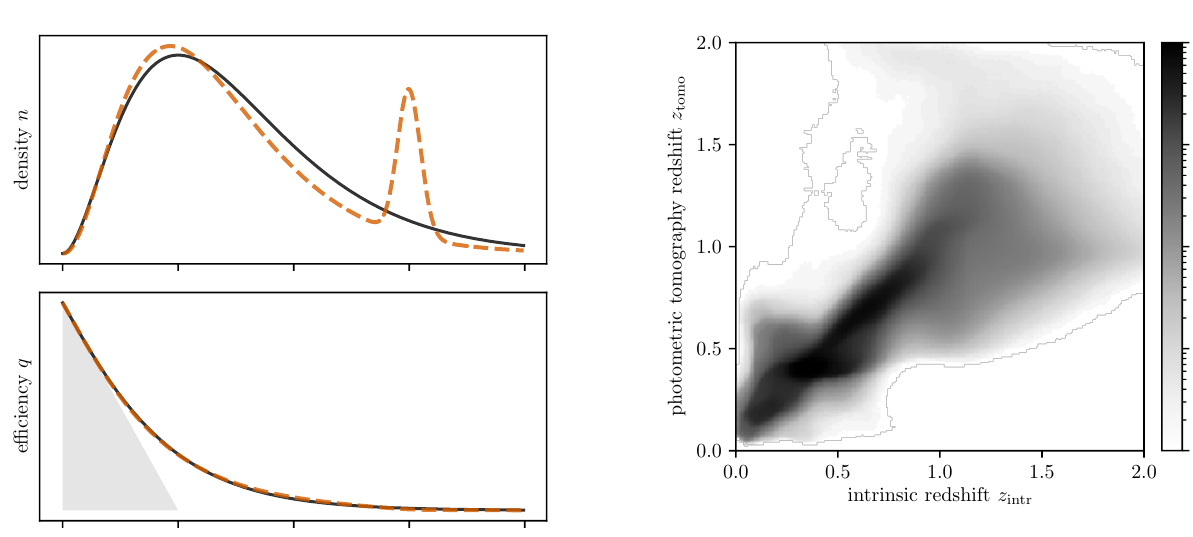
Figure 2. Two-dimensional distribution of intrinsic redshifts z intr and the photometric redshifts z tomo used for tomographic binning. Source selection into tomographic bins corresponds to horizontal cuts in the plane. Since the distribution is not purely diagonal, this creates complicated intrinsic redshift distributions when using photometric